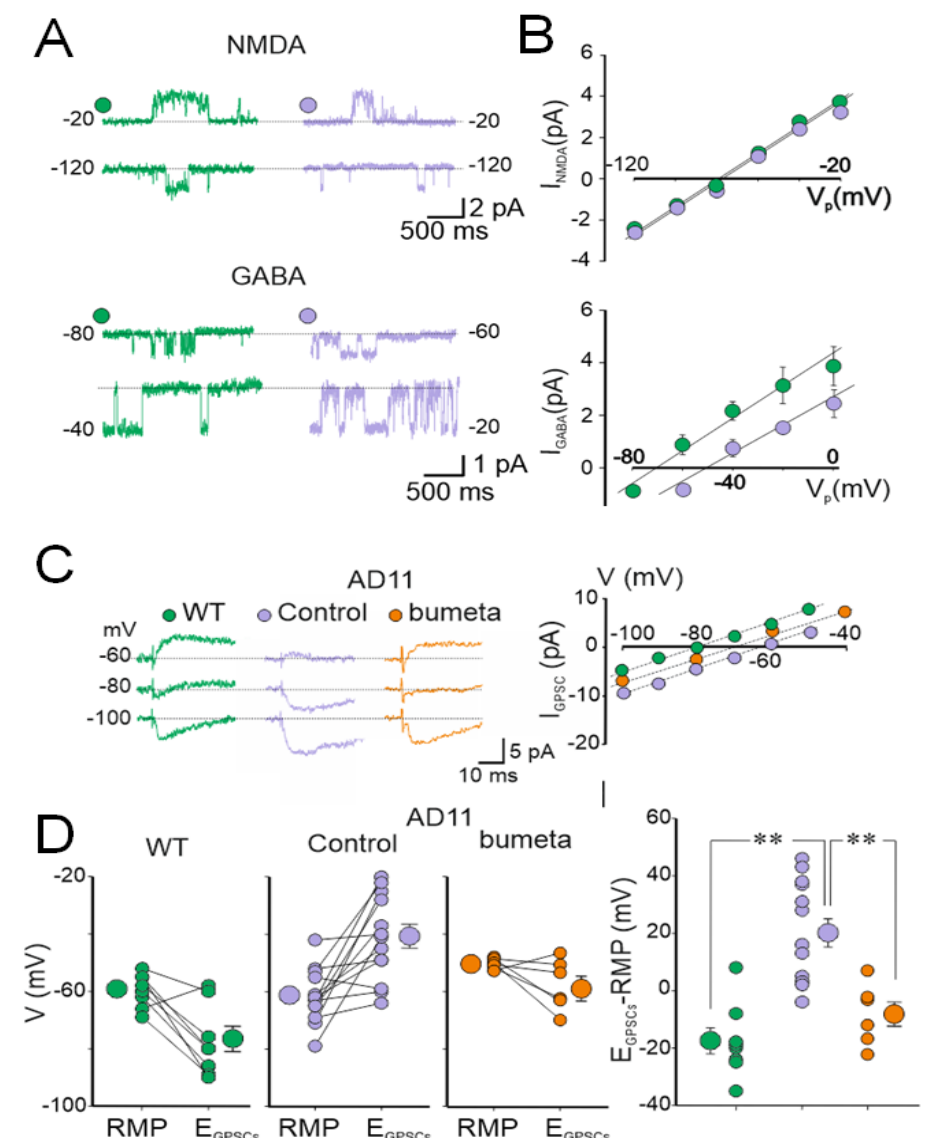
Figure 2. Depolarizing action of GABA in six-month-old AD11 mice. ( A ) Cell-attached recordings of single NMDA and GABA A receptor channels obtained at two different pipette potentials in neurons from WT (green) and AD11 (violet) mice. ( B ) Summary plot of single NMDA (I NMDA ) and GABA (I GABA ) currents versus pipette potentials (Vp). Single NMDA currents reversed at − 75.3 mV and − 76.2 mV in WT and AD11 mice, respectively. Assuming a reversal of NMDA currents equal to 0 mV, we estimated a mean resting membrane potential of − 75mV and − 76 mV, respectively. In contrast, single GABA A currents reversed at − 76 mV and at − 56 mV in WT and AD11 mice, respectively. ( C ) Left: Perforated patch recordings of GPSCs evoked in CA3 principal cells by local stimulation of GABAergic interneurons in the presence of DNQX (20 µ M) and D-AP-5 (50 µ M) at three different holding potentials in hippocampal slices from WT (green), AD11 (violet), and AD11 mice exposed to bumetanide (yellow). Right: Synaptic currents (I GPSCs ) shown in A are plotted versus membrane potentials (Vm). ( D ) Left: individual RMPs and E GPSCs values in hippocampal slices obtained from WT (green), AD11 (violet), and AD11 exposed to bumetanide (yellow). Larger symbols on the left and right refer to mean ± SEM values. Right: plot of the driving force for GABA A (E GABA –RMP) in individual experiments from the three different groups of mice. ** p < 0.001 (Modified from